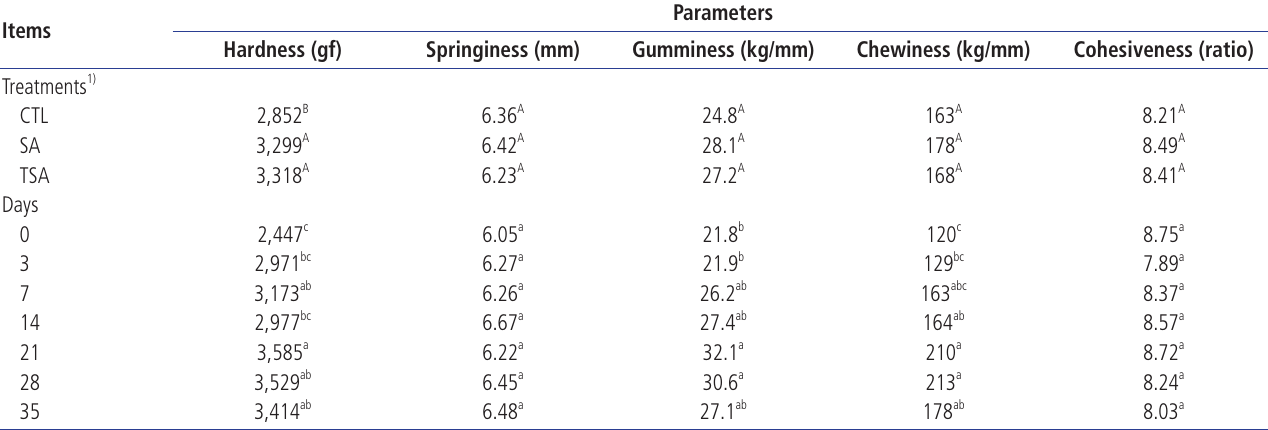
Table 3. Texture profile analyses of low-fat pork sausages wrapped with SA and TSA films